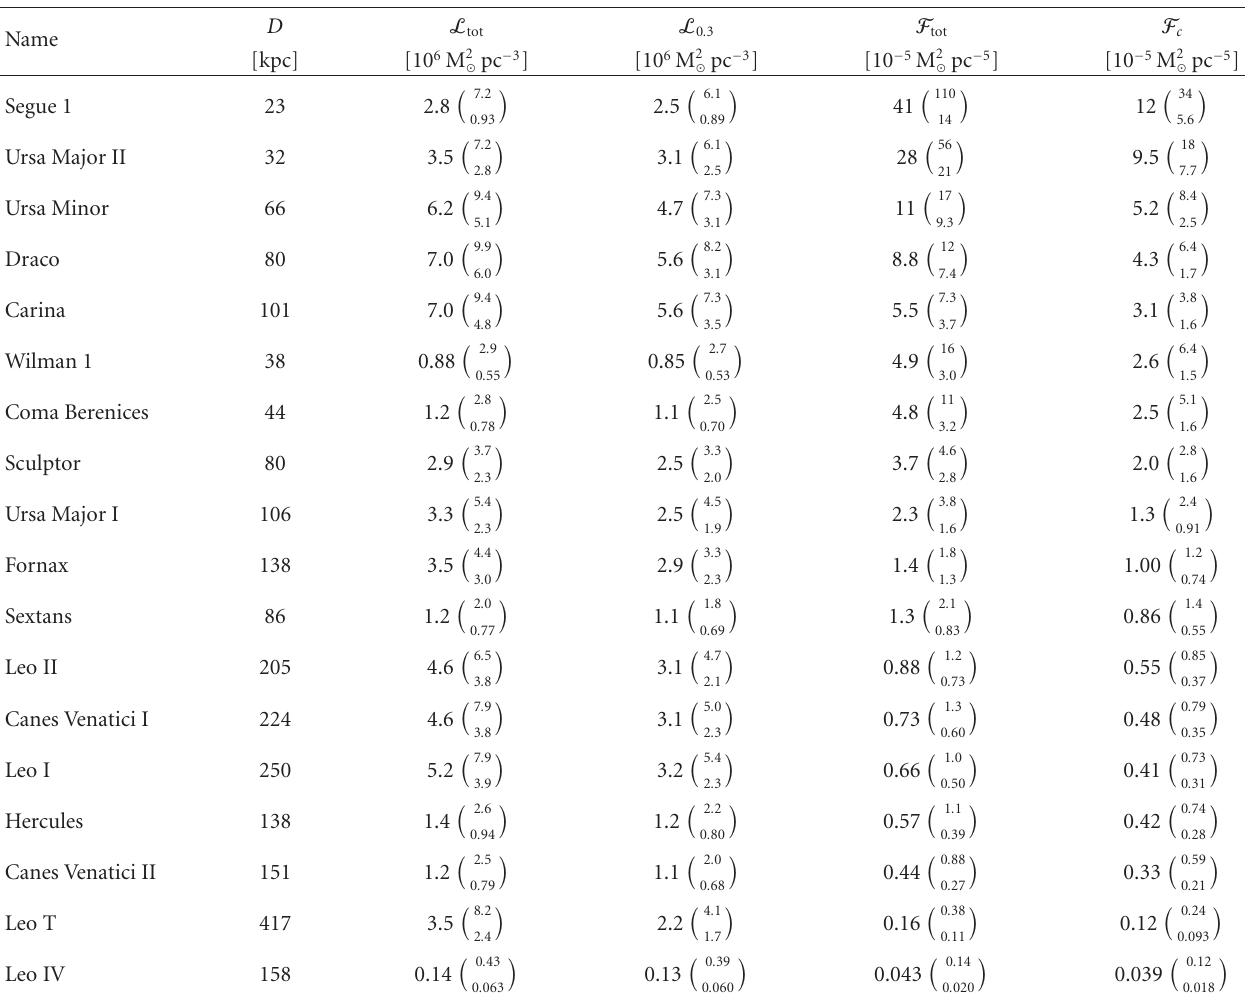
Table 2: Estimated luminosities and fluxes for the 18 dSph from Table 1. L tot is the total luminosity and L 0 . 3 the luminosity from within the central 0.3 kpc. F tot = L tot / 4 πD 2 is the total flux and F c the flux from a central region subtending 0 . 15 ◦ (about the angular resolution of Fermi above 3GeV). The first number is the median over all subhalos matching the dSph distance and M 0 . 3 , the numbers in parentheses are the 16th and 84th percentiles. The table is ordered by decreasing F tot